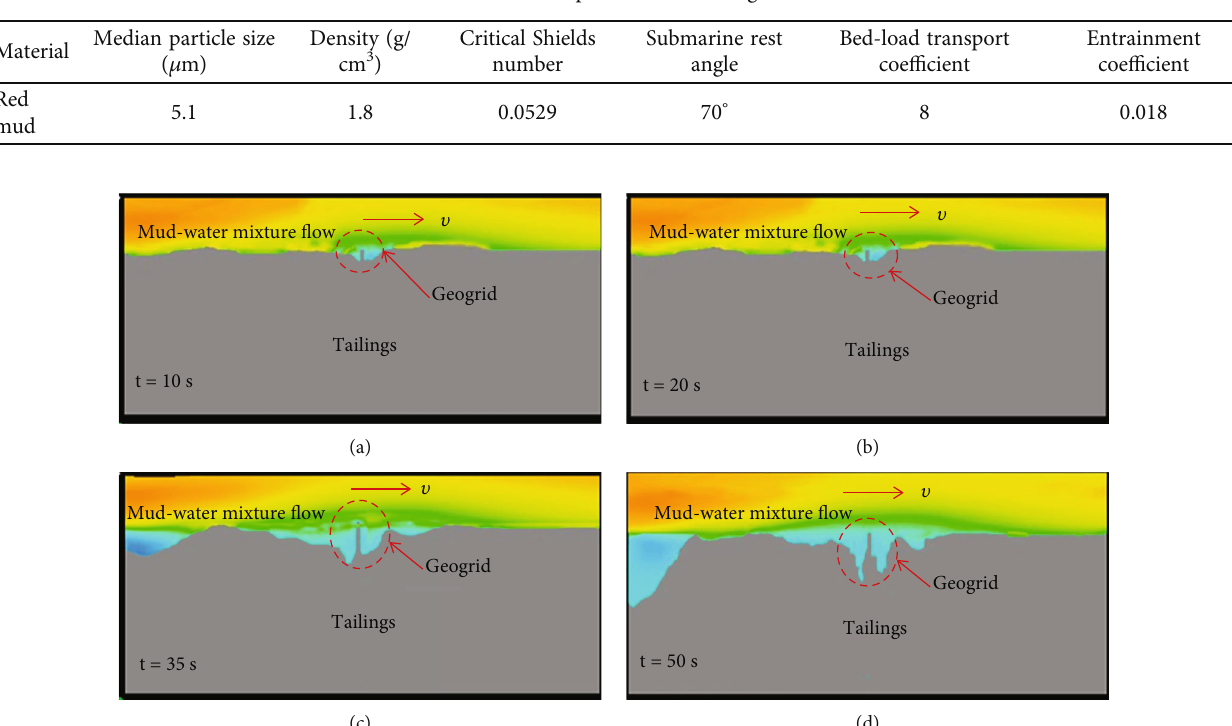
Figure 13: The cross-sectional view of erosion changes at four stages: (a) the simulation time =10 s, (b) the simulation time =20 s, (c) the simulation time=35 s, and (d) the simulation time =50